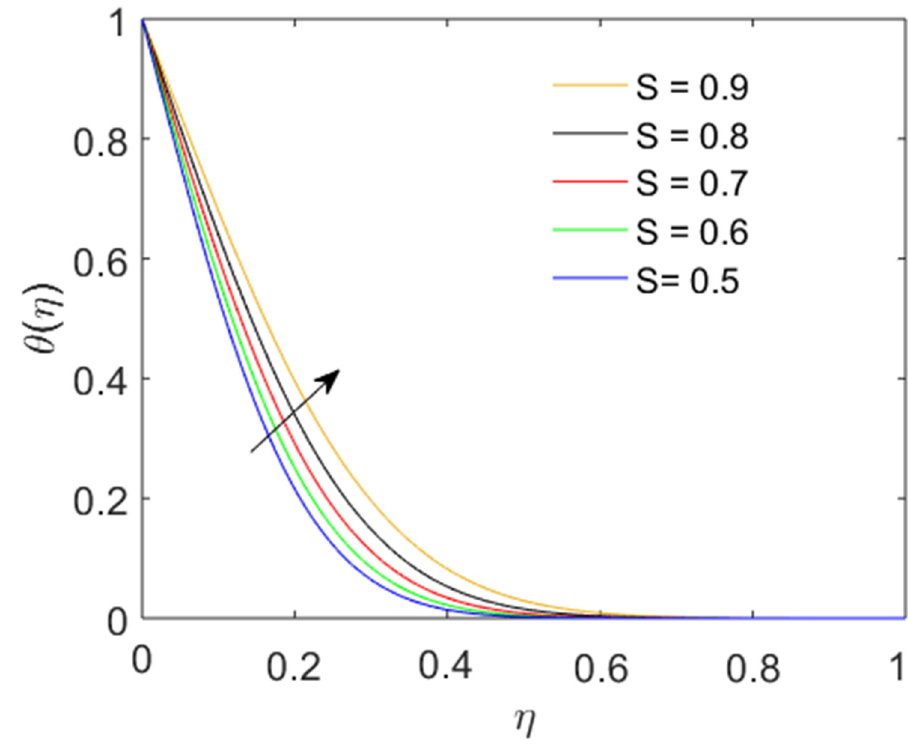
Figure 8. Impact of the disk fluctuation parameter on the thermal